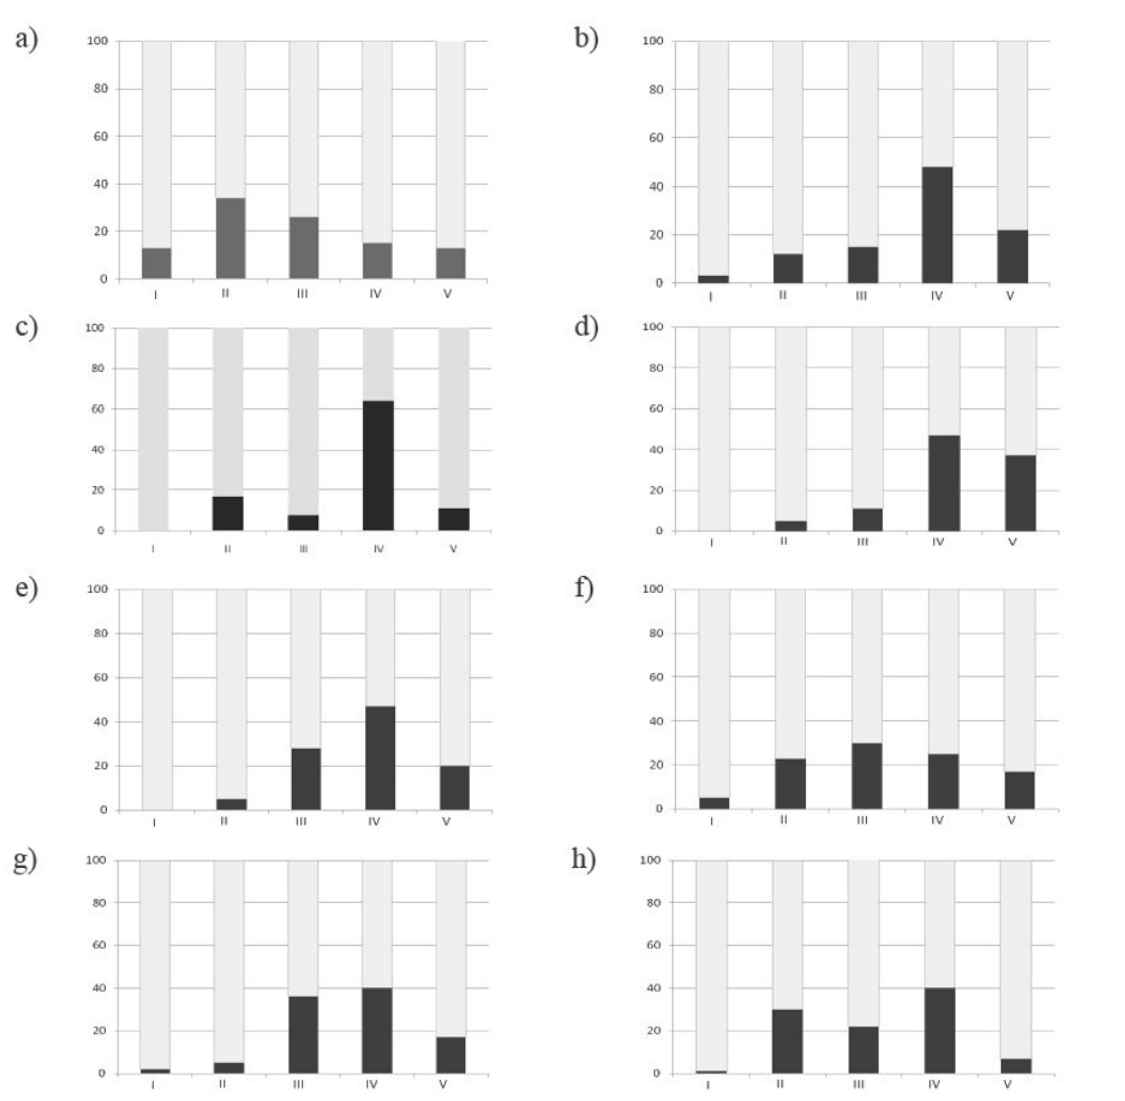
Figure 5. Example of metal distribution in particular fractions (Kielce Lake, between July 2009 and May 2010), where a) Mn, b) Zn, c) Cu, d) Ni, e) Cr, f) Pb, g) Fe and h)